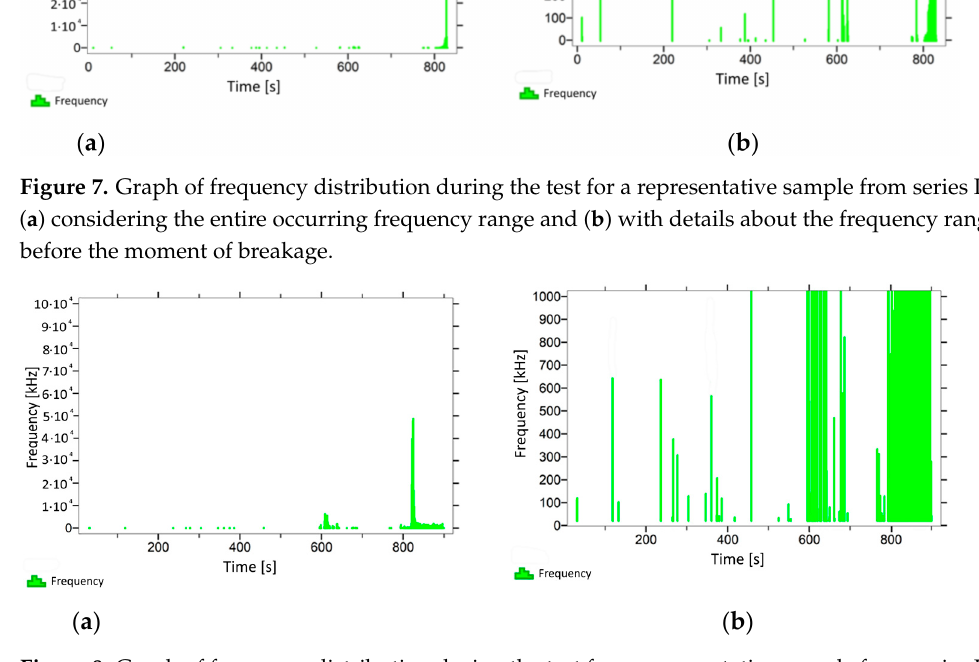
Figure 9. Graph of frequency distribution during the test for a representative sample from series P 8 : ( a ) considering the entire occurring frequency range and ( b ) with details about the frequency range before the moment of breakage.